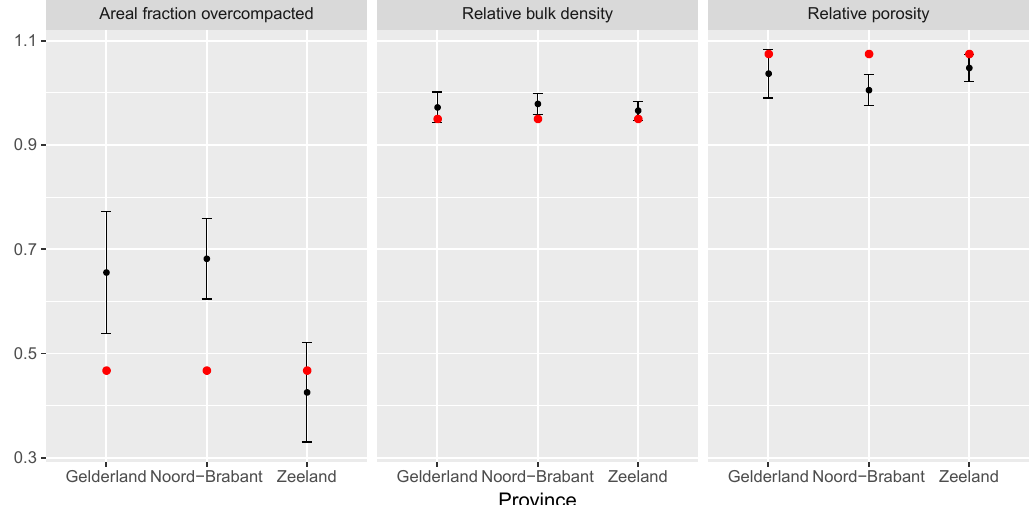
Figure 4. Estimated means of subsoil compaction parameters and areal fractions of overcompacted subsoils for high-risk group of map units (units 3, 4 and 5) in the three provinces. The error bars indicate the standard error of the estimated means or areal fraction. The red dots are the estimated means or areal fraction for the Netherlands.